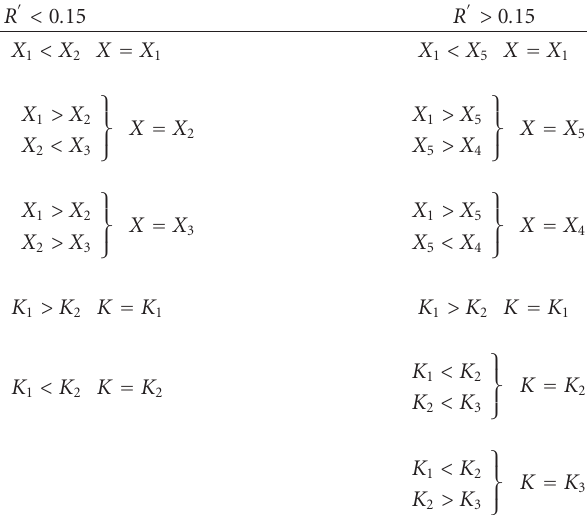
Table 3: Choice of X and K for the Katto and Ohno model. R (cid:8) < 0 .